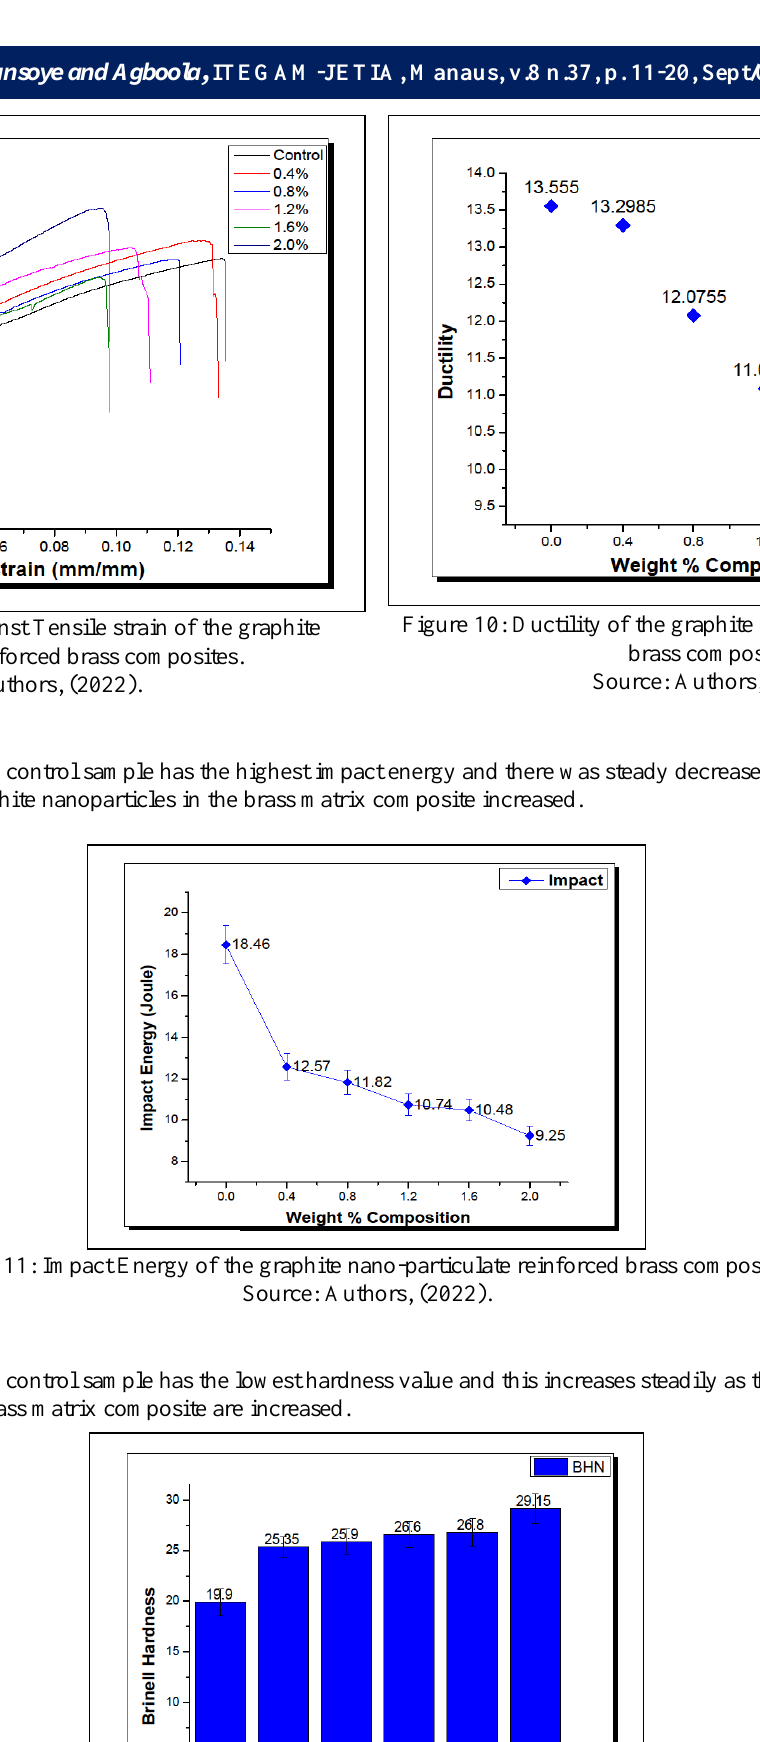
Figure 12: Brinell hardness of the graphite nano-particulate reinforced brass composites. Source: Authors,